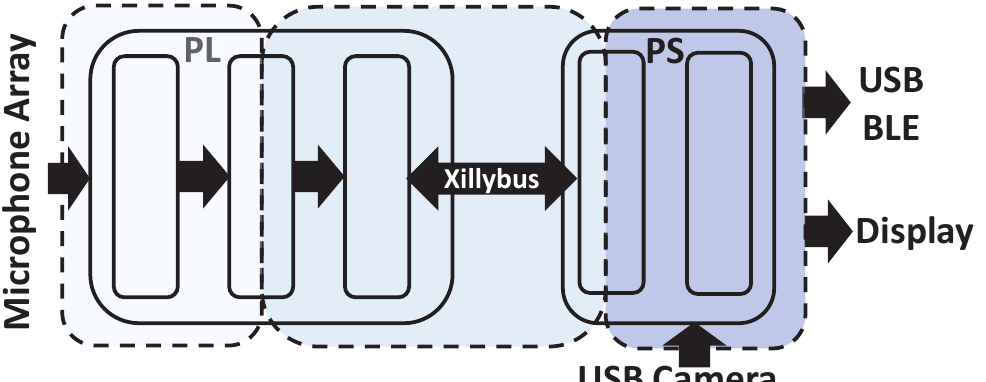
Figure 13. The proposed architecture operates at three different rates to reduce consumed resources and to optimize the execution time.